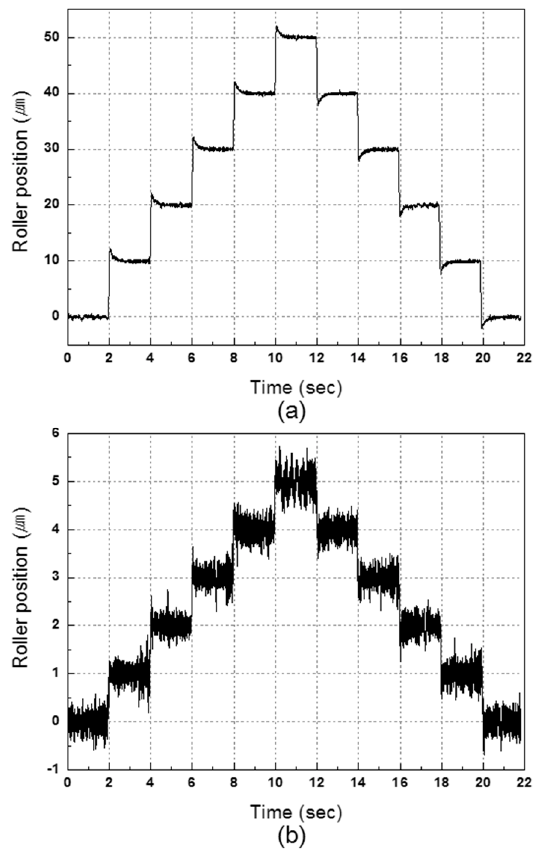
Figure 9. Step movement test results of the roller with magnetic bearings: ( a ) 10 µ m movement; and ( b ) 1 µ m movement.